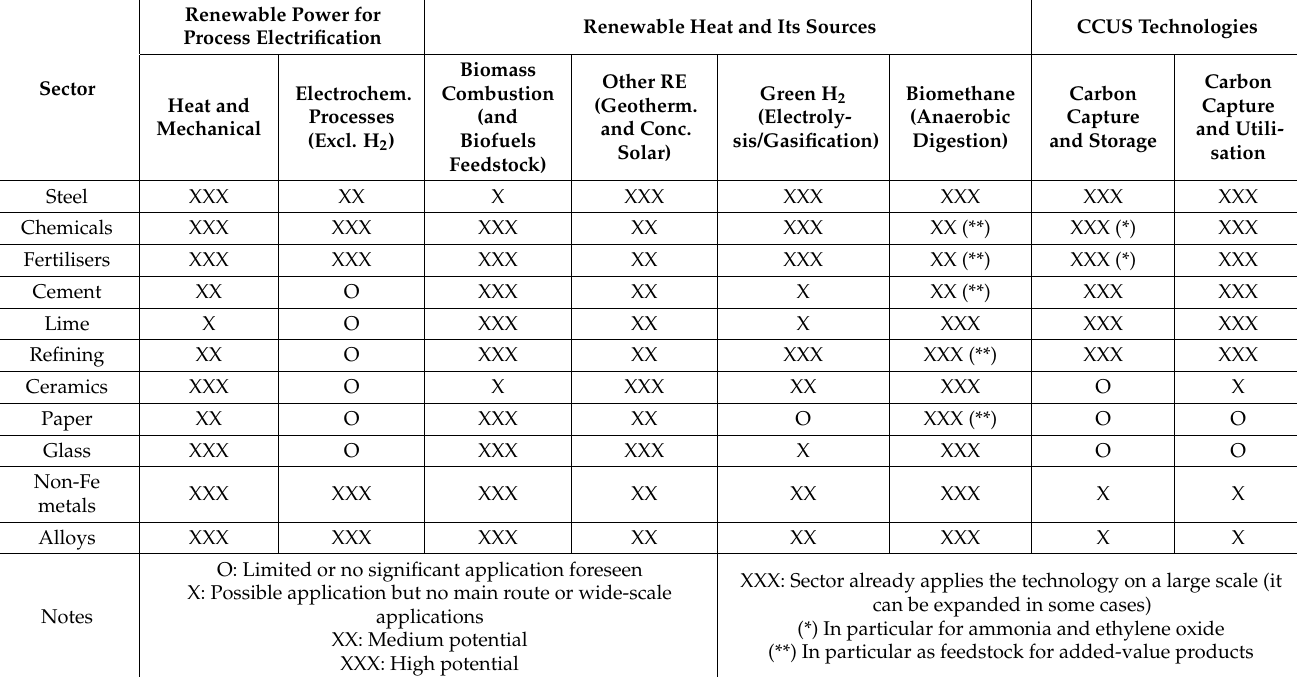
Table adapted from the original source: